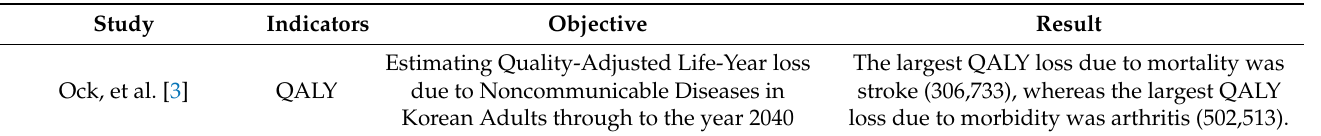
Table 2. Studies using QALY/DALY indicators used to investigate the economic burden of